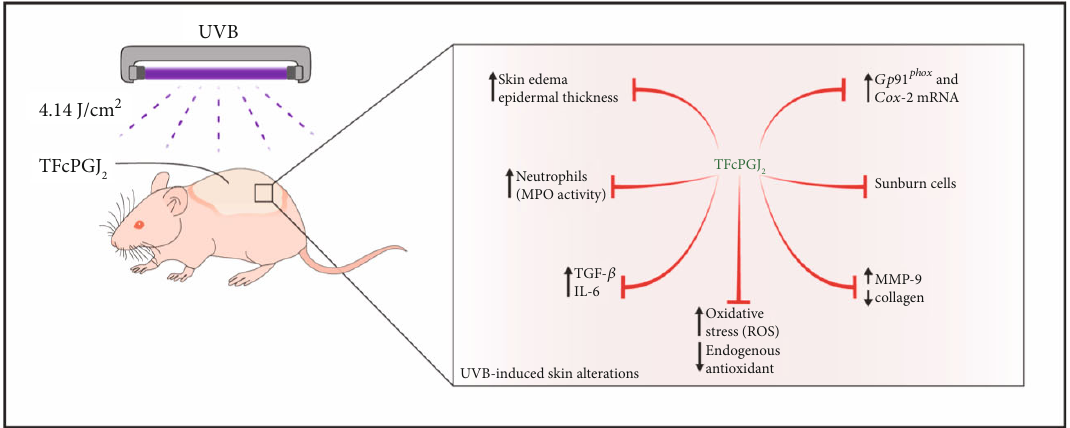
Figure 10: Schematic representation of the e ff ects of topical formulation containing 15d-PGJ irradiation. UVB causes in fl ammatory disease signs such as skin edema as well as pathological alterations in the skin including sunburn cell formation, an increase of mast cell counts, thickening of the epidermis, and collagen degradation. These phenomena are explained by the induction of neutrophil recruitment observed as myeloperoxidase (MPO) activity, metalloproteinase-9 (MMP-9) activity, reactive oxygen species (ROS) production, depletion of endogenous antioxidants, enhanced mRNA expression of enzymes involved in the production of ROS and in fl ammatory mediators such as gp91 phox and cyclooxygenase-2 (COX-2), and cytokine production (TGF- β and IL-6). All these UVB pathological modi fi cations in the skin were inhibited by TFcPGJ mentioned in the schematic fi